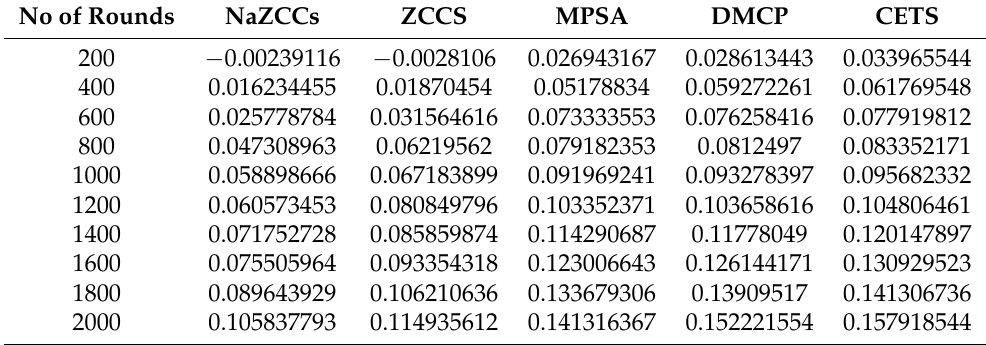
Table 11. CETS versus other models on energy overhead per round at hop density